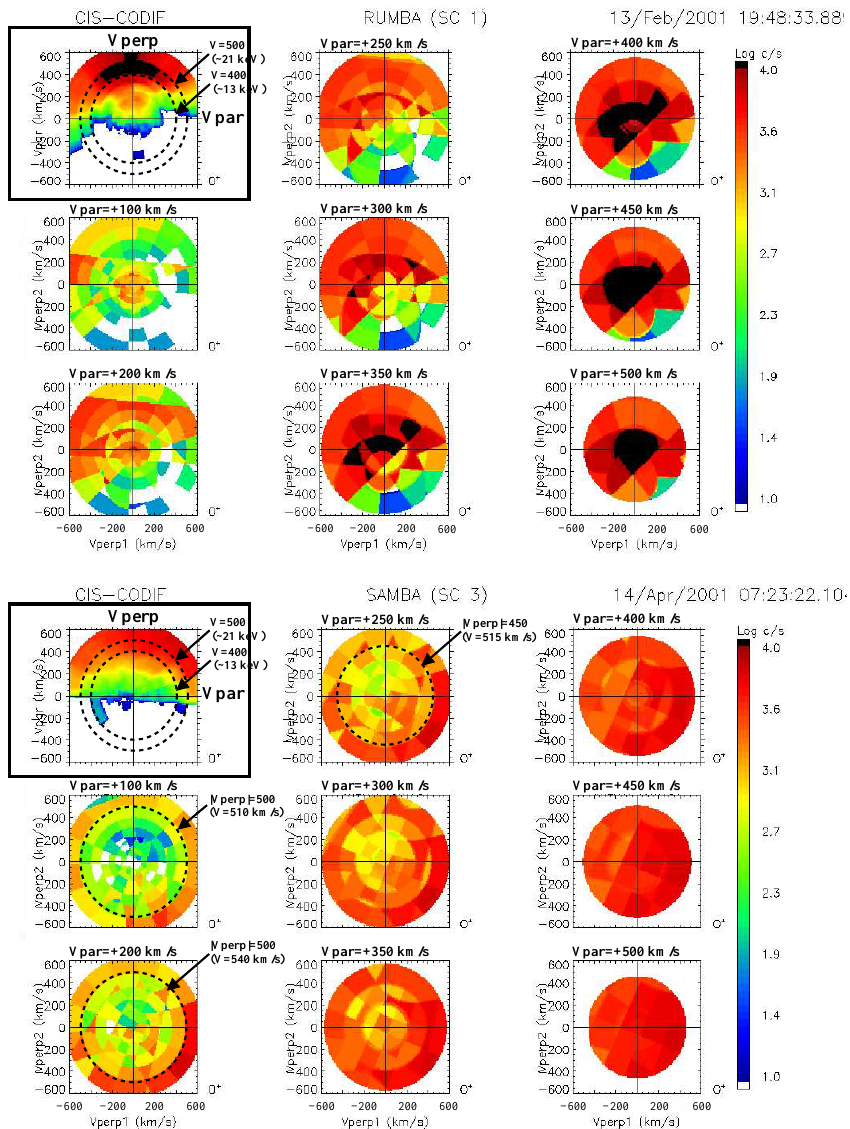
Fig. 5. O + ion velocity distributions in counts per second (c/s) observed by the Cluster S/C-1 on 13 February 2001 (upper) and the Cluster S/C-3 on 14 April 2001 (lower). They were presumably observed in the dayside cusp. The + V par direction corresponds to the upward direction along the geomagnetic field in these cases. The construction of the panels is the same as that of Fig. 2.